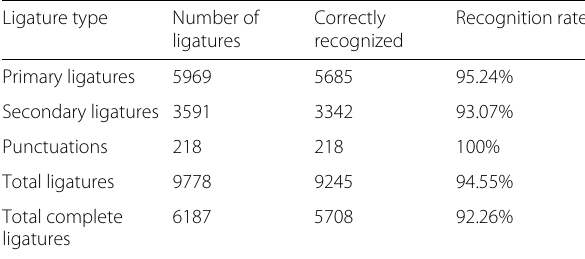
Table 8 Recognition rates of (primary, secondary,